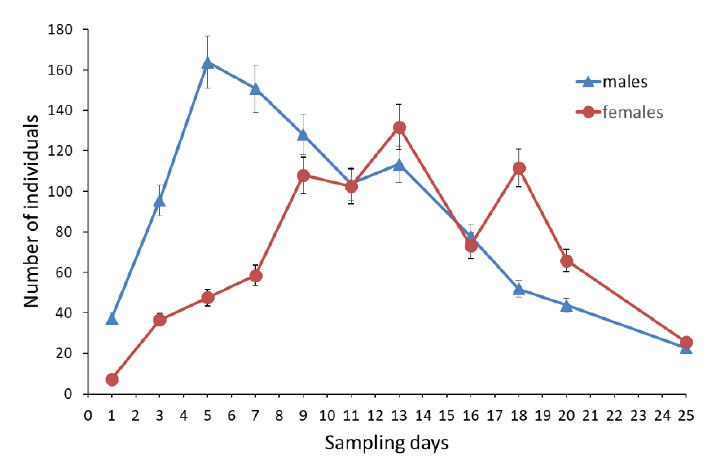
Figure 4. Dynamics of daily numbers of males and females throughout the flight period based on Jolly-Seber model estimates. Error bars represent SEs.